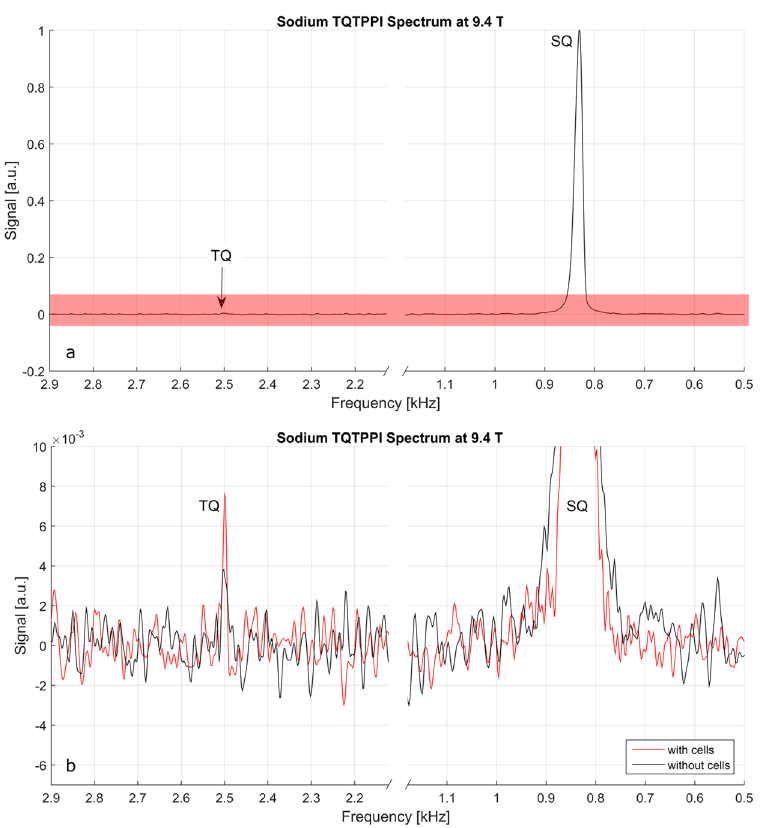
Figure 4. ( a ) Sodium TQTPPI spectrum without cells in full height. The single quantum (SQ) resonance dominates the spectrum. There seems to be no triple quantum contribution. ( b ) Zoomed section of the TQTPPI spectrum (depicted by the red bar in ( a )). Without cells (black line) a very weak TQ contribution can be observed. Living cells (red line) lead to a markedly higher TQ